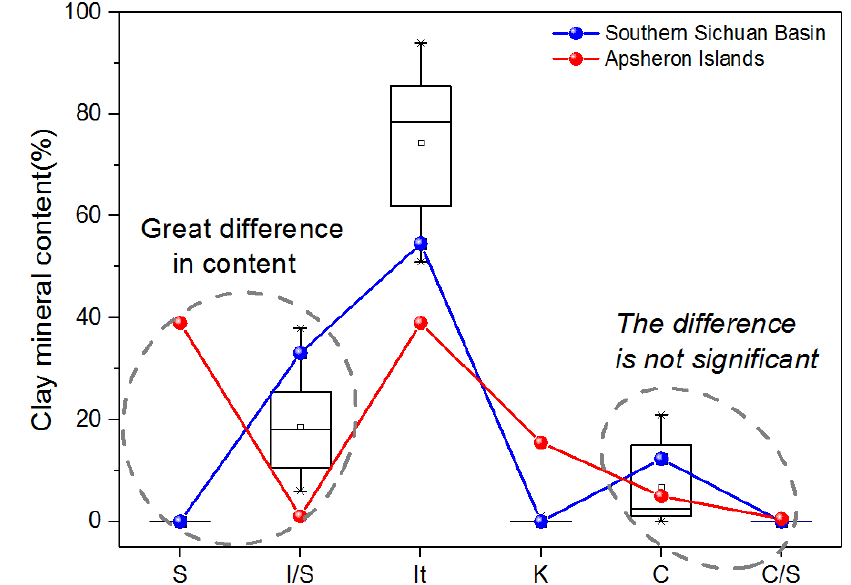
Figure 9. Box figure of the shale clay mineral composition distribution in the study area. The blue line is the average of the results of a previous study [38]. The red line is the average clay mineral content at the 6 km depth in the overpressure oilfield in the Apsheron Islands [39].